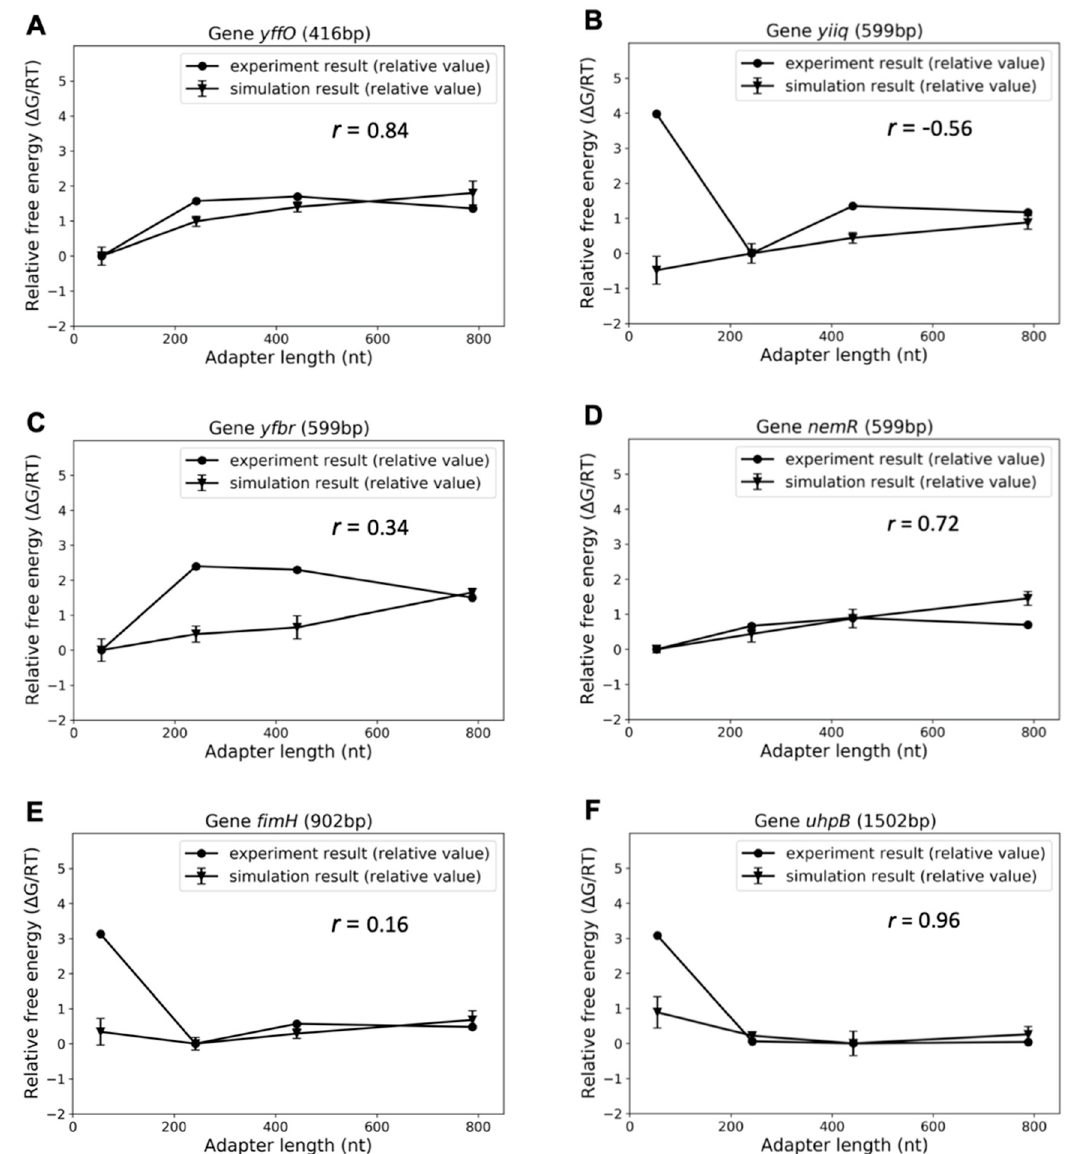
Figure 4. Comparison between free energy of probe–target interaction from experiments and simulation results. A – F represent six groups for data for six genes. The Pearson correlation coefficients are labeled as r value in the figures.